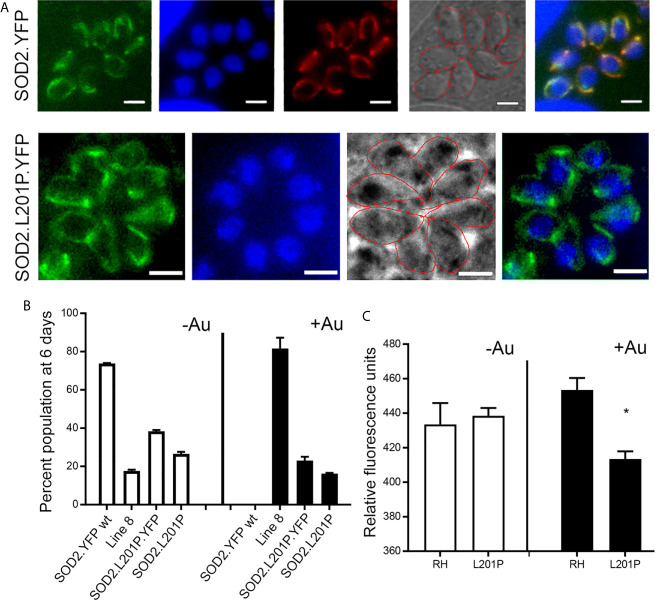
A L201P mutation in TgSOD2 does not alter localization of TgSOD2 or confer resistance to auranofin. (A) Wild type and mutant SOD2-YFP exhibit a mitochondrial distribution. Mitochondrion was stained red with the anti-F1B ATPase. Scale bar: 5 µm. (B) Growth competition assays indicate that the L201P mutation is associated with reduced fitness in the absence of auranofin (control conditions, white bars). In the presence of auranofin (black bars), only line 8 shows growth advantage, indicating that the single L201P mutation to TgSOD2 does not confer resistance. (C) In the absence of auranofin, the SOD2.L201P line accumulated ROS similarly to wild type parasites, consistent with its auranofin-sensitive growth; however, it accumulated less ROS in the presence of auranofin. *p < 0.05 when compared to RH in auranofin (+Au).